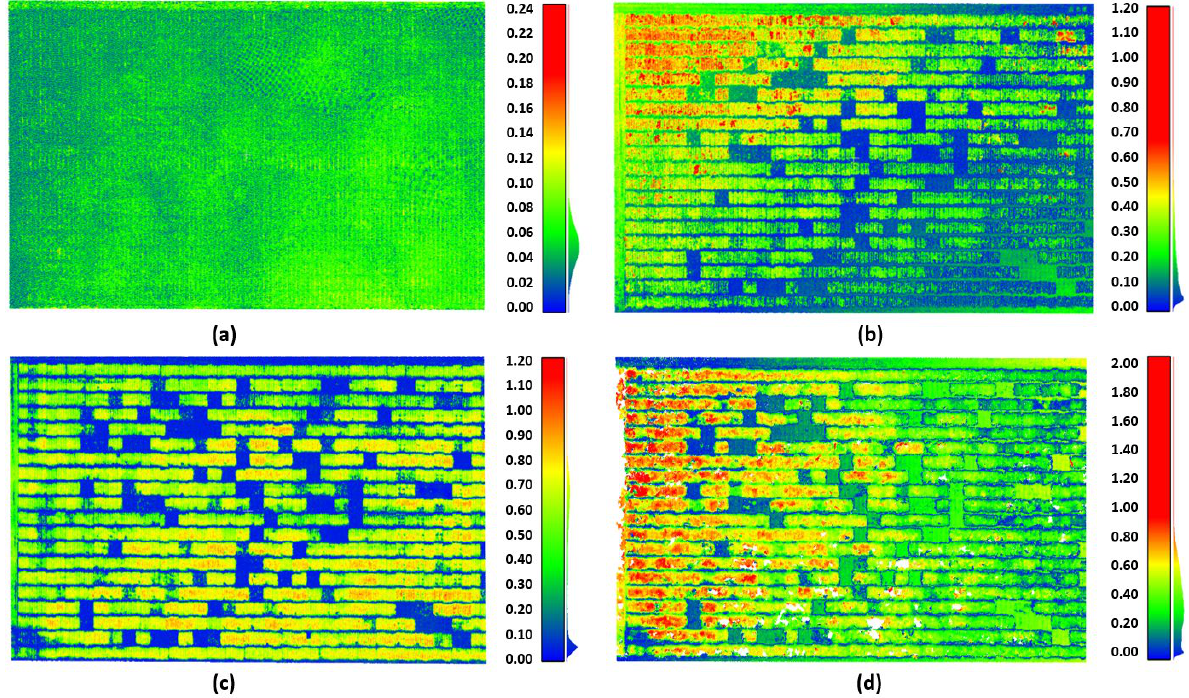
Figure 3: Deviation point clouds over Soybean using DAP 14 as reference at: (a) DAP 27, (b) DAP 44, (c) DAP 56 and (d) DAP 79, in meters .